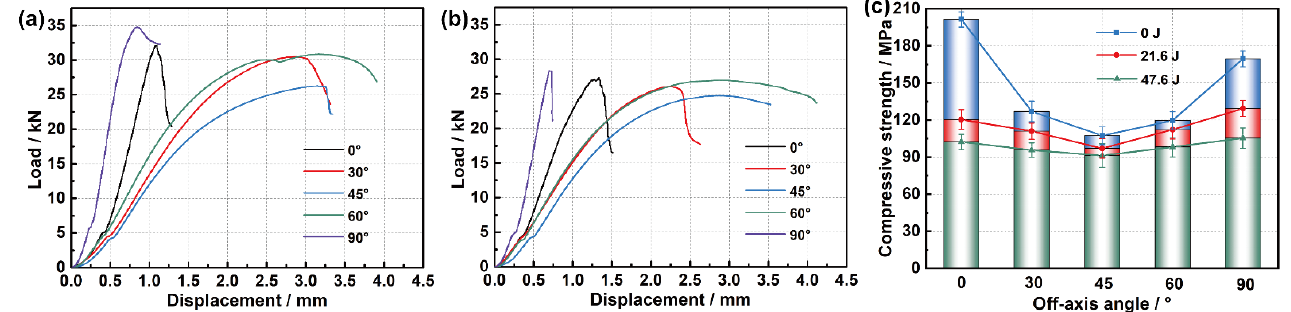
Figure 10. CAI responses: ( a ) load-displacement curves under 21.6 J of impact energy; ( b ) load-displacement curves under 47.6 J of impact energy; ( c ) CAI strength under various impact energies.